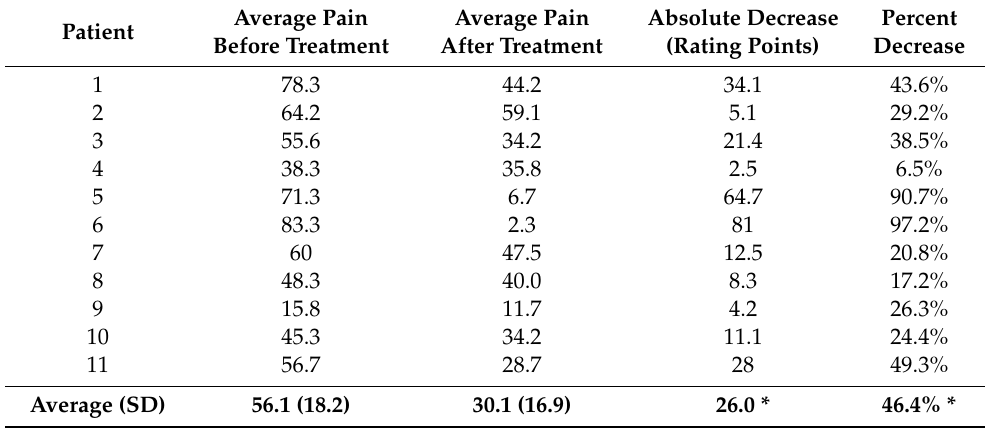
Table 2. Average values of pain ratings for each patient before and after treatment with agmatine sulfate. The di ff erences between average rating point values are also expressed as percentages 1 .